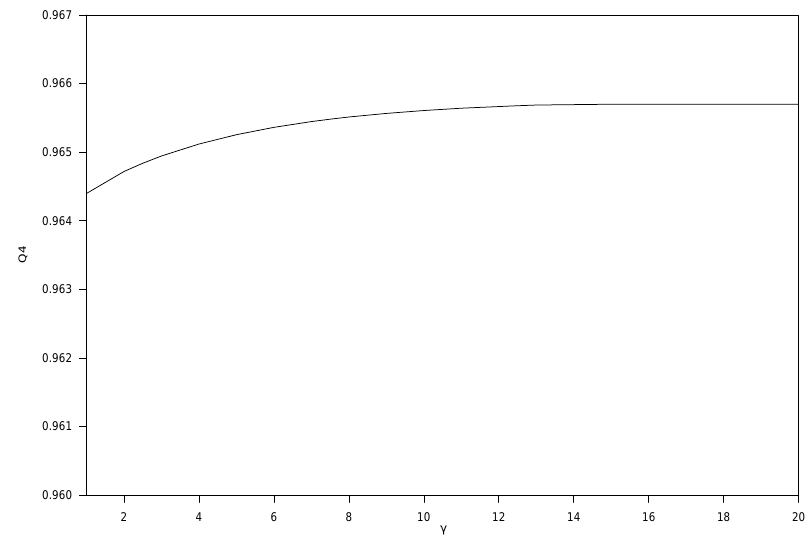
Figure 7. Relationship between Q4 and γ